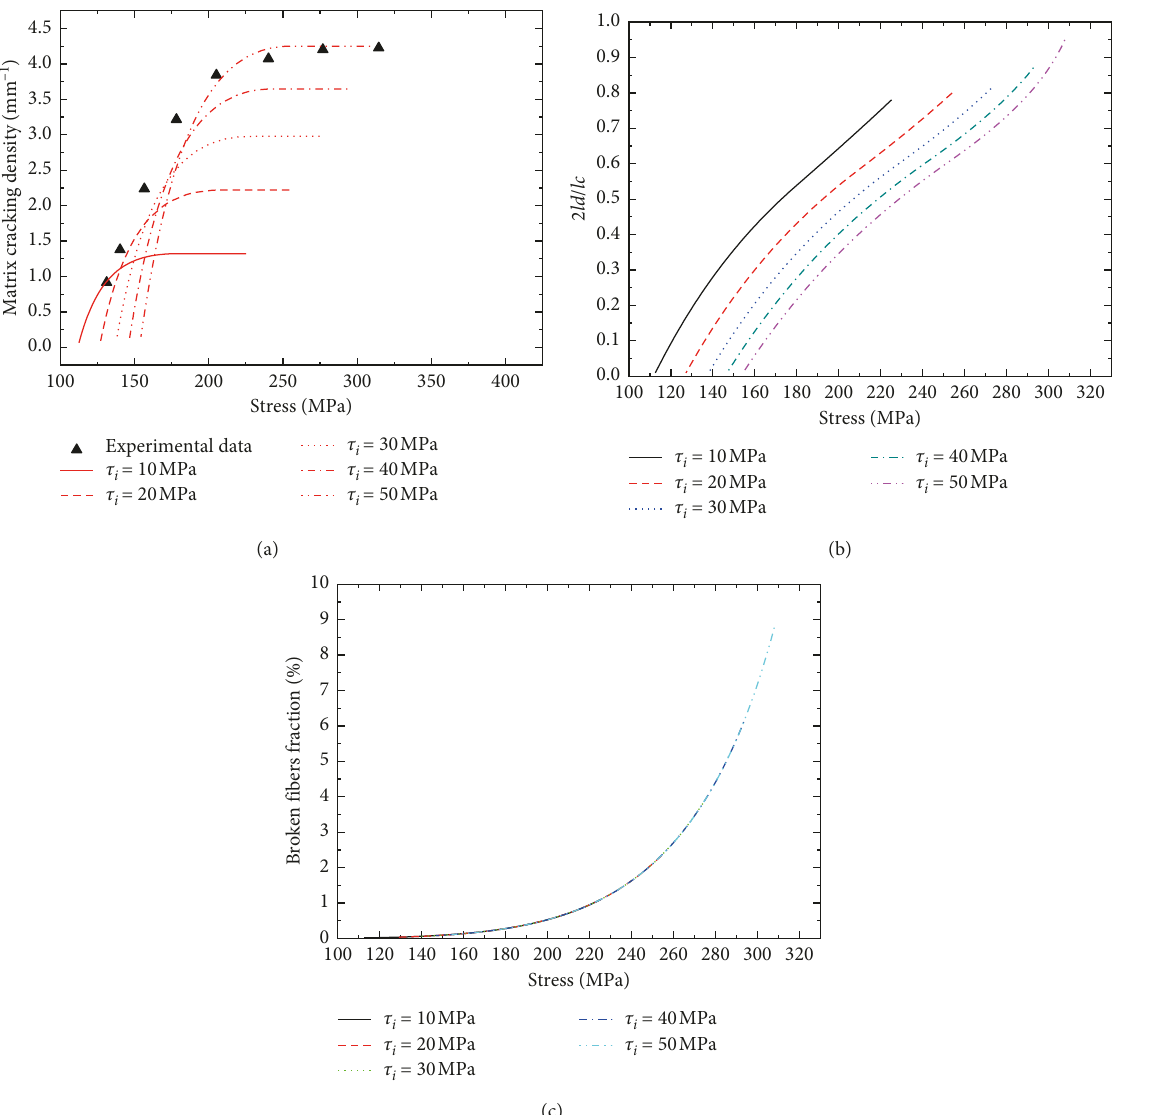
Figure 9: (a) The experimental and predicted matrix cracking density versus the applied stress curves; (b) the interface debonding length versus the applied stress curves; (c) the broken fibers fraction versus the applied stress curves of 2D Hi-Nicalon ™ SiC/SiC